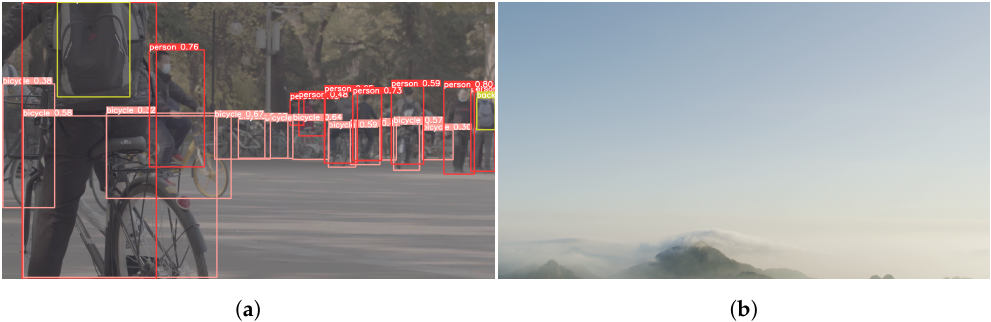
Figure 2. Results of YOLOv5-based object detection in two frames of video sequences: ( a ) most objects are detected; ( b ) no object is